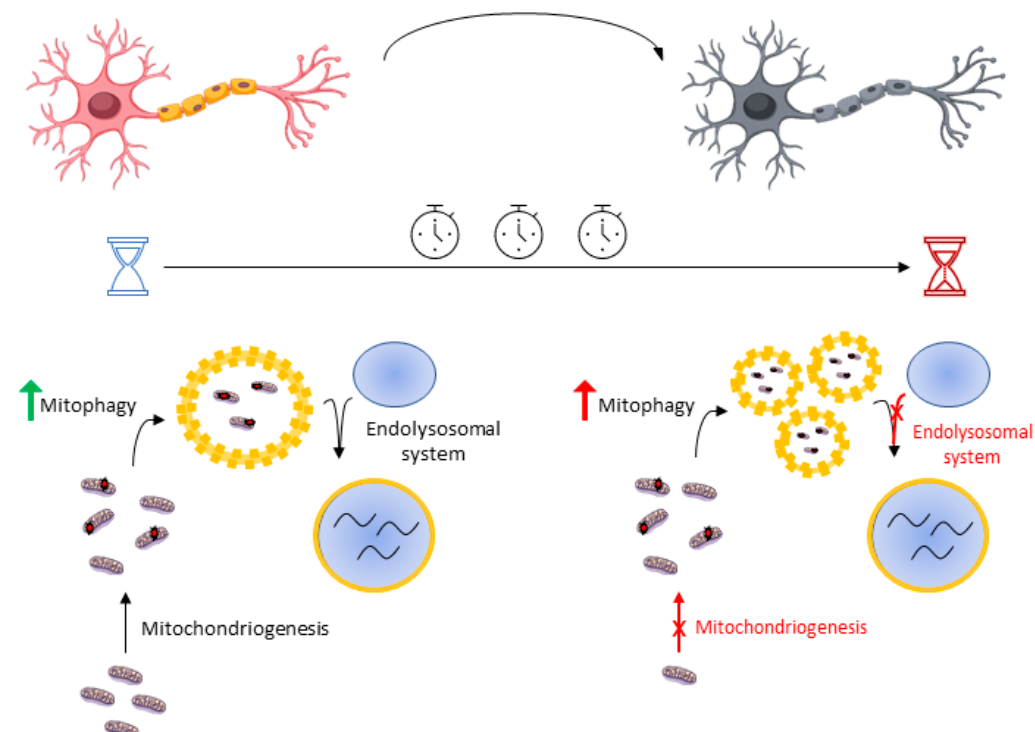
Figure 3. Mitophagy induction shows different effects at early and late stages. Boosting mitophagy may be beneficial in the short term as mitochondriogenesis and the endolysosomal system work properly. However, this strategy may be detrimental in the long term due to progressive defects in both mitochondriogenesis and the endolysosomal system, resulting in the accumulation of nonfunctional vacuolated